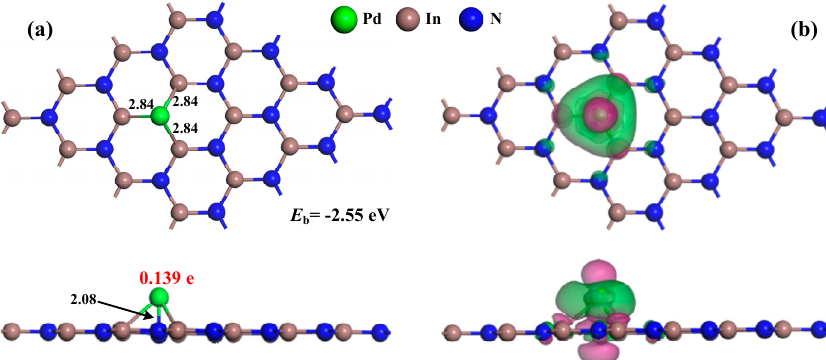
Figure 1. Configuration ( a ) and EDD ( b ) of the Pd-InN monolayer. The black values are bond lengths while the red value is the charge of the Pd dopant. In EDD, the green and rosy regions represent electron accumulation and depletion, respectively. The isosurface is set to 0.005 eV/Å 3 .